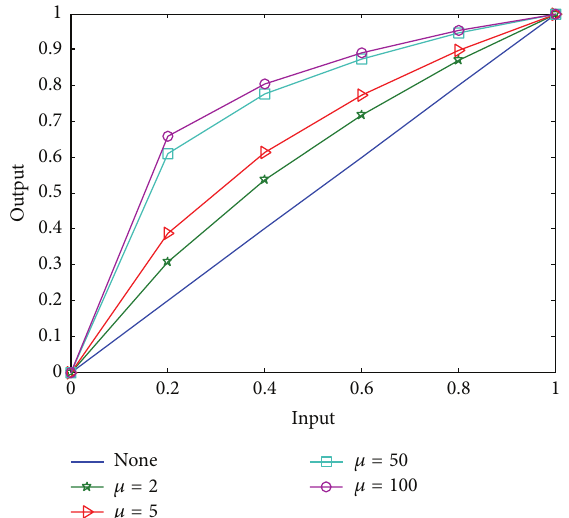
Figure 1: Characteristic curve of companding